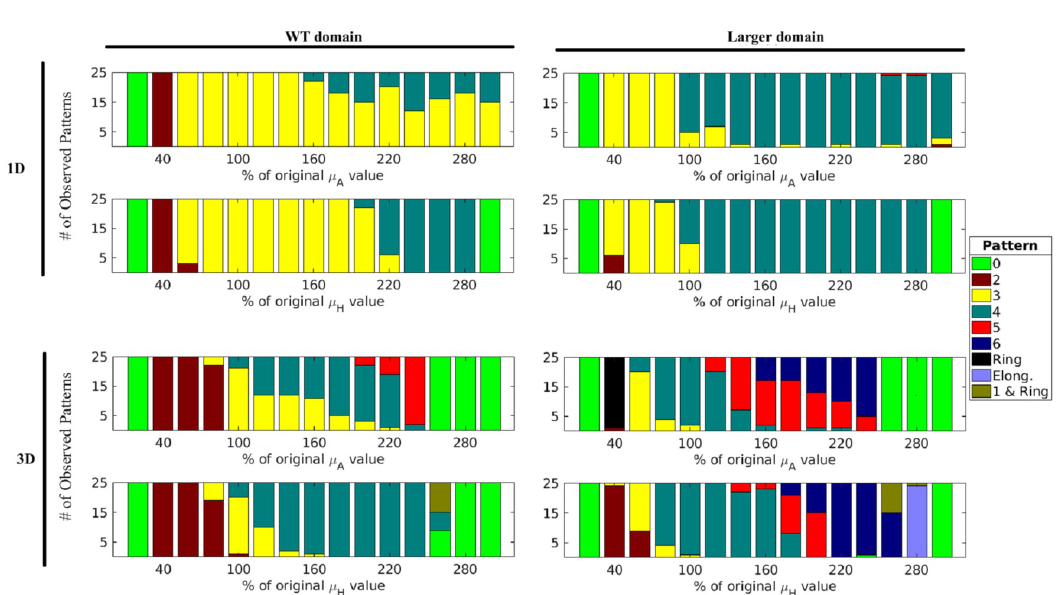
Fig 6. Increase in the morphogen decay leads to an increase in spike number. In both domains, an increase in decay of either the activator ( μ , top rows) or the inhibitor ( μ , bottom rows) led to an increase in the number of spikes. “Ring” represents increased A H morphogen concentration along a great circle, “1 and Ring” represents a single spike located at a pole of the sphere combined with a ring located on the opposite side of the sphere, and “Elong.” represents six elongated spikes located on the edges of a tetrahedron. The values of the decay parameters were varied from 20% to 300% of their original values from Table